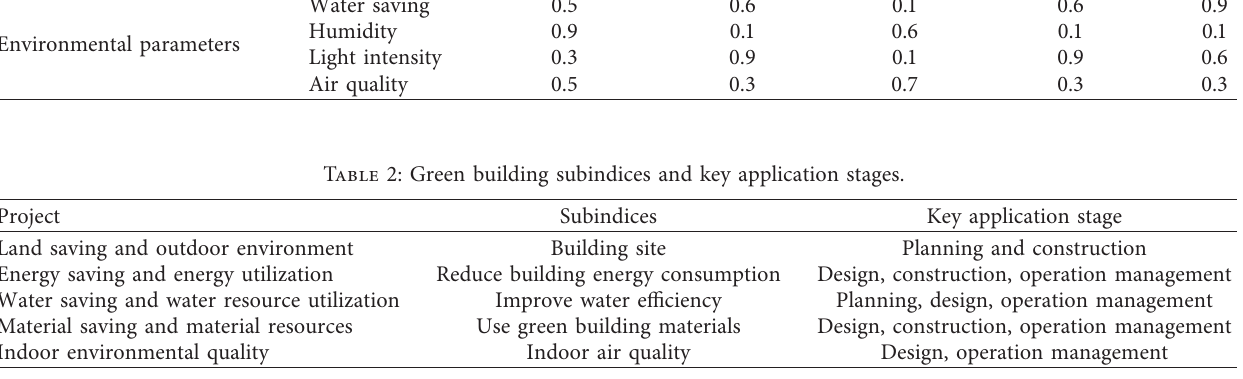
Table 1: Degree of influence of environmental parameters.